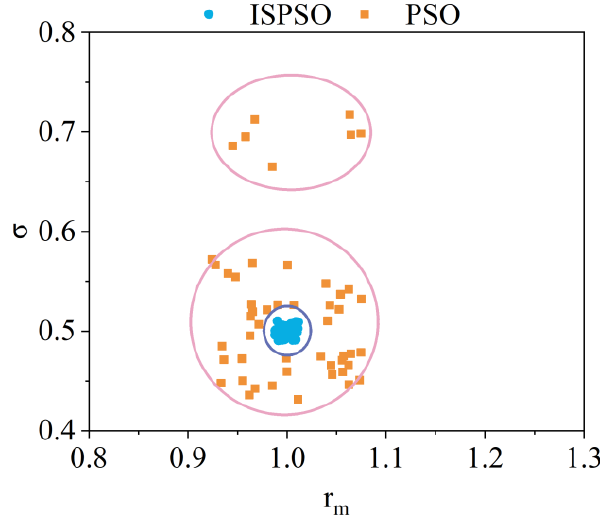
Figure 5. The 50-times calculation of ISPSO and PSO algorithms.